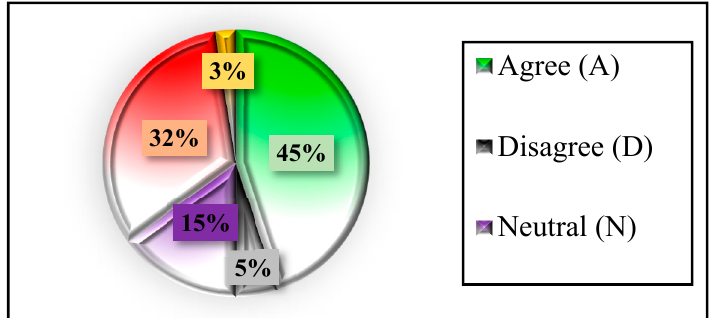
Figure 9. Review of project procedures for project management.